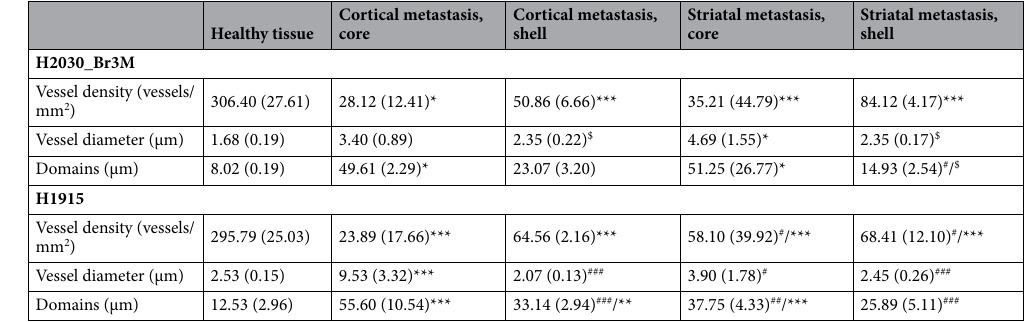
Table 1. Quantification of the RECA-1 immunostaining. Data represent the mean (SD) of vessels density and diameter and domains analyzed with histology for H2030-Br3M and H1915. Mean ± SD, n = 3, * p < 0.05,